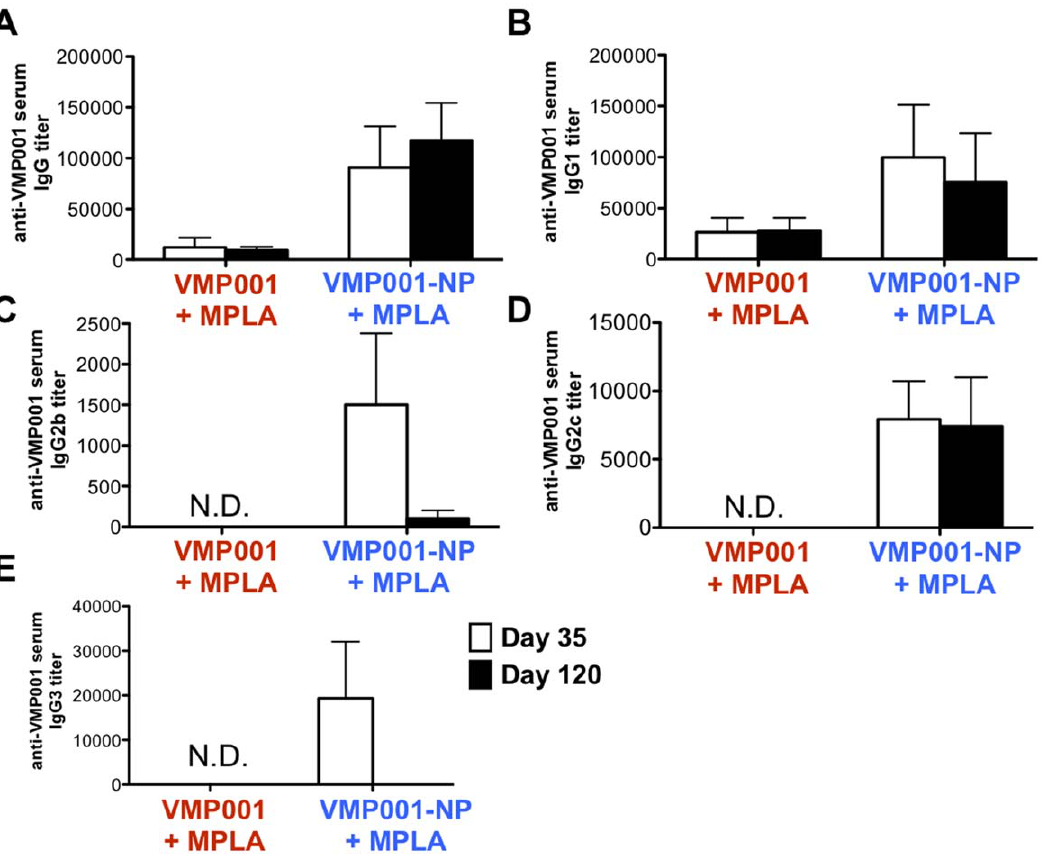
Figure 3. Immunization with VMP001-NPs elicits Th1/Th2 balanced antibody responses. (A) C57Bl/6 mice were immunized s.c. on days 0 and 21 with 25 m g of MPLA and 1 m g of VMP001 in either soluble or VMP001-NP formulations, and anti-VMP001 IgG sera were characterized on days 35 and 120 for (A) IgG, (B) IgG 1 , (C) IgG 2b , (D) IgG 2c , and (E) IgG 3 titers.